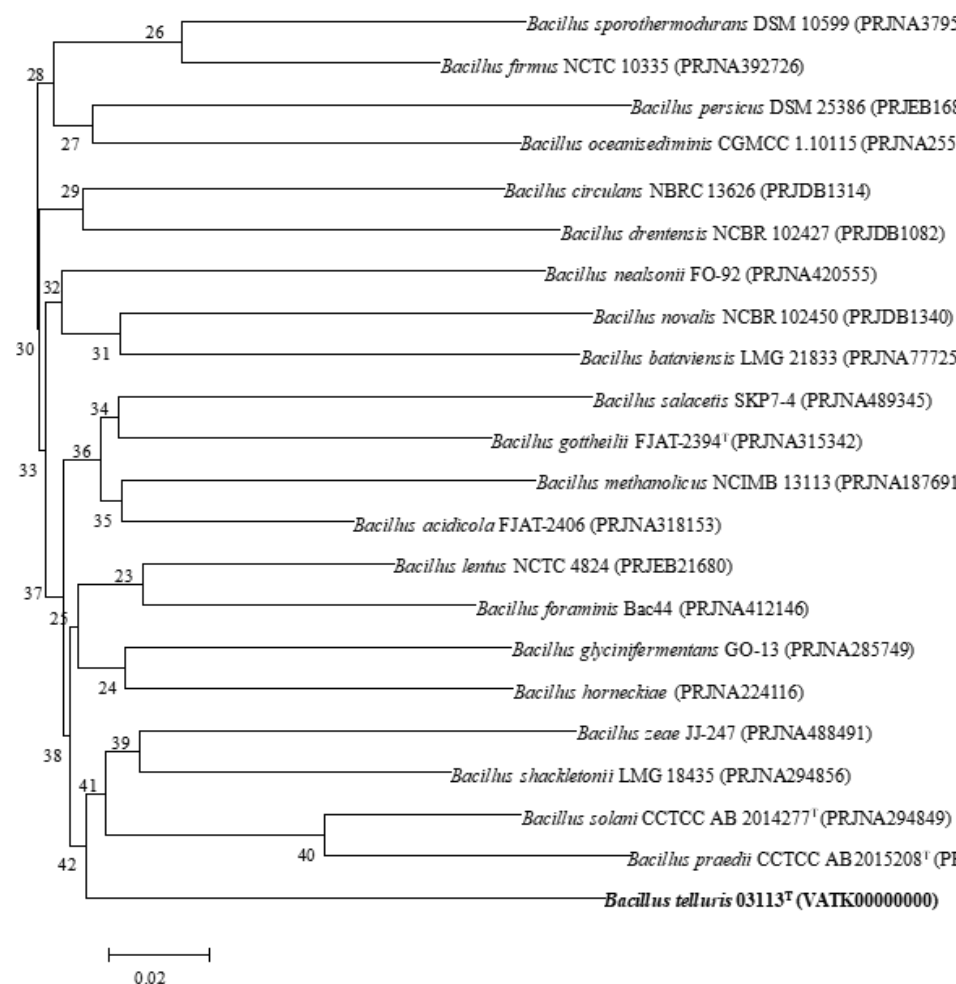
Figure 2. Phylogenomic tree generated with Genome-to-Genome Distance Calculator (GGDC), showing the phylogenomic position of strain 03113 T and the type strains of related species of Bacillus . The numbers at the nodes indicate the gene support index. Bar, 0.02 substitutions per position.